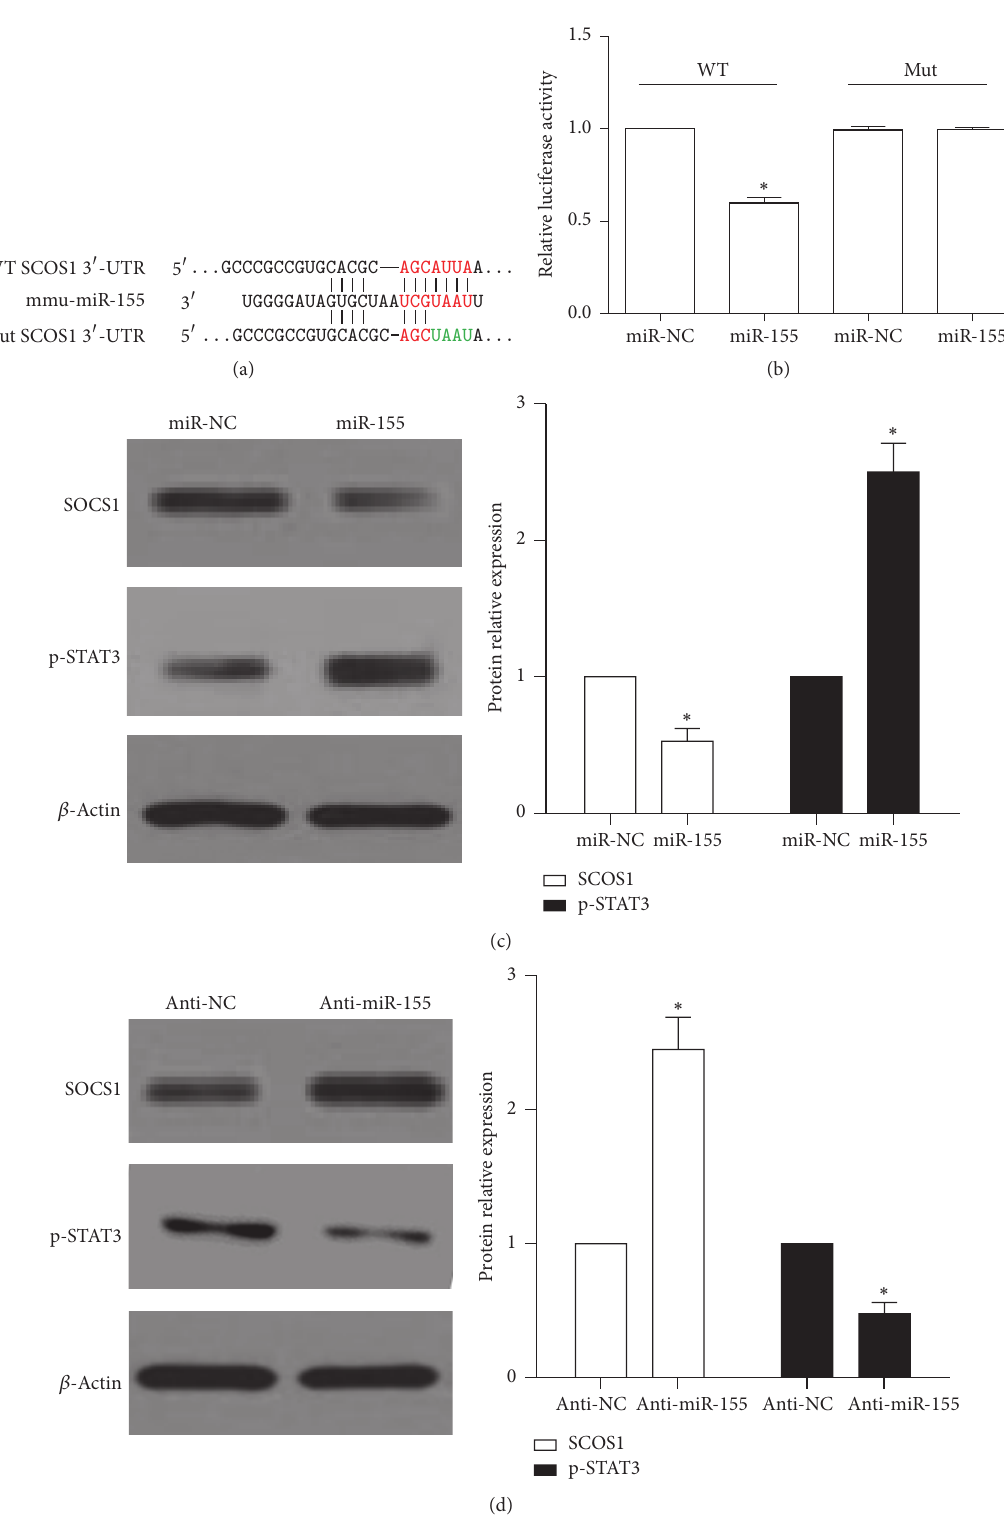
Figure 5: miR-155 regulated directly SOCS1-STAT3 signal pathway. (a) Schematic of the interaction sites of 3 󸀠 UTR SOCS1 wild-type (WT) or mutation (Mut) with miR-155. (b) Luciferase reporter assay was used to validate miR-155 binding SOCS1 3 󸀠 UTR in HEK293FT cells. The luciferase reporter plasmids carrying the WT or Mut 3 󸀠 UTRof SOCS1 and miR-155 mimic/miR-negative control (NC) were cotransfected into HEK 293FT cells for 24 h, and then luciferase activity was detected: ∗ 𝑝 < 0.05 , relative to miR-NC group. (c) and (d) Western blot analyzed the protein expression of SOCS1 and p-STAT3 after miR-155 mimic, anti-miR-155, and miR-NC was transfected into RAW264.7 cells for 48 h, respectively: ∗ 𝑝 < 0.05 , relative to miR-NC group. The data are presented as the mean ± SE of three separate